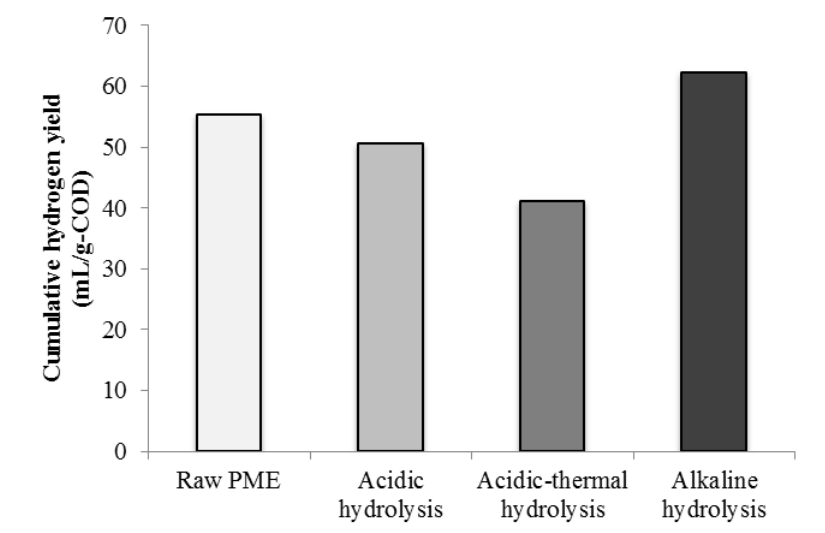
Fig. 3 Hydrogen potential of PME in respect to the type of